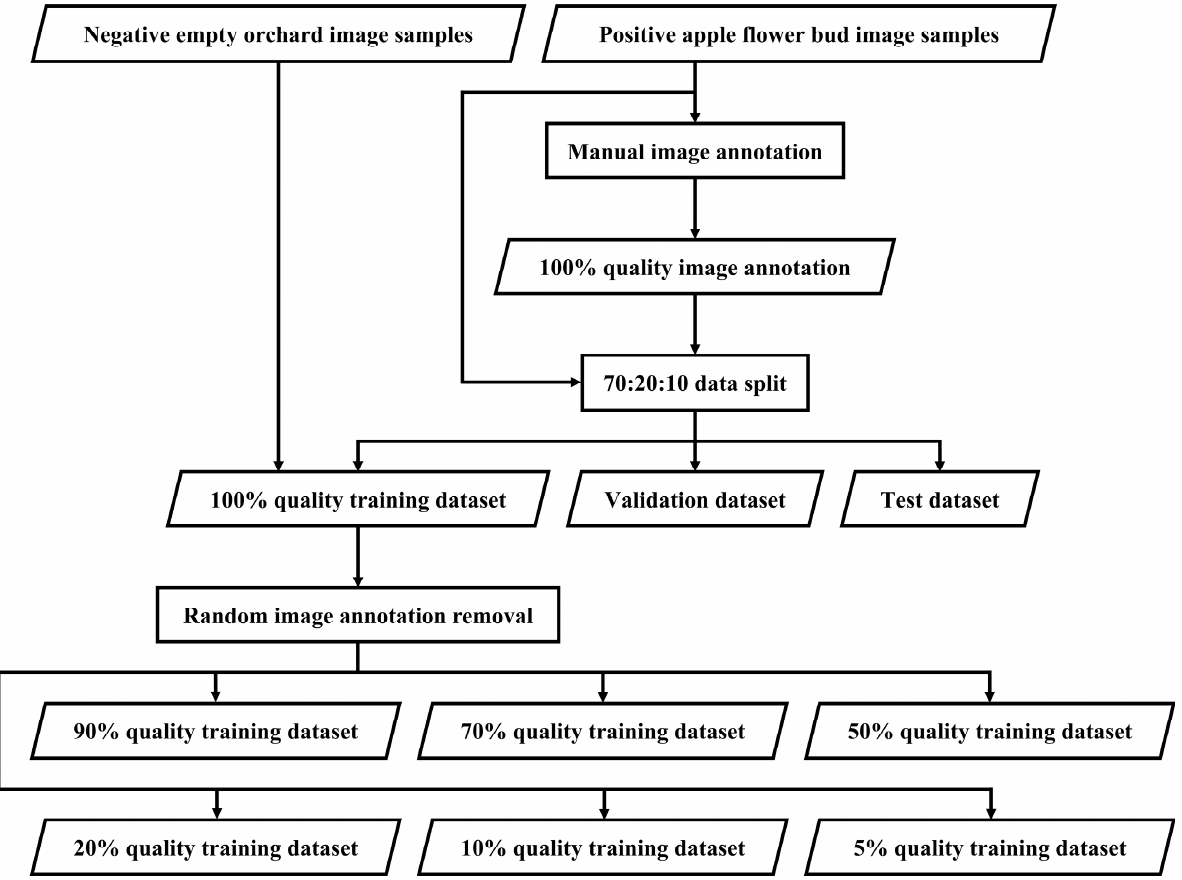
Figure 1. Flowchart of the preparation process for the seven training datasets with different image annotation qualities, one common validation dataset, and one common test dataset.